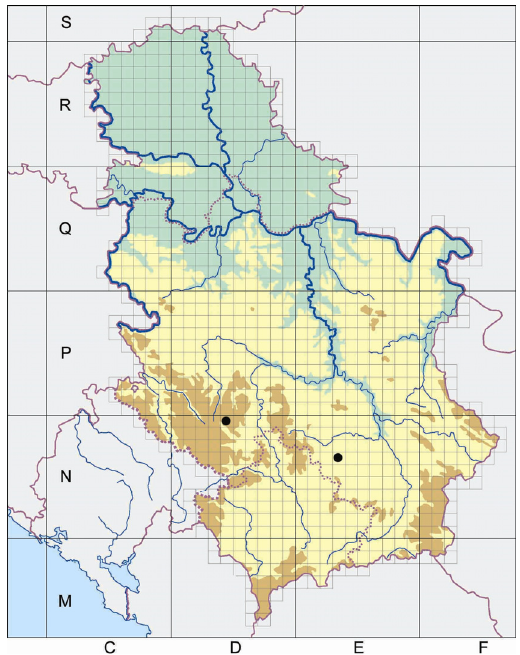
Figure 2. The UTM map of Serbia with labeled localities of plant material collection (Golija-left and